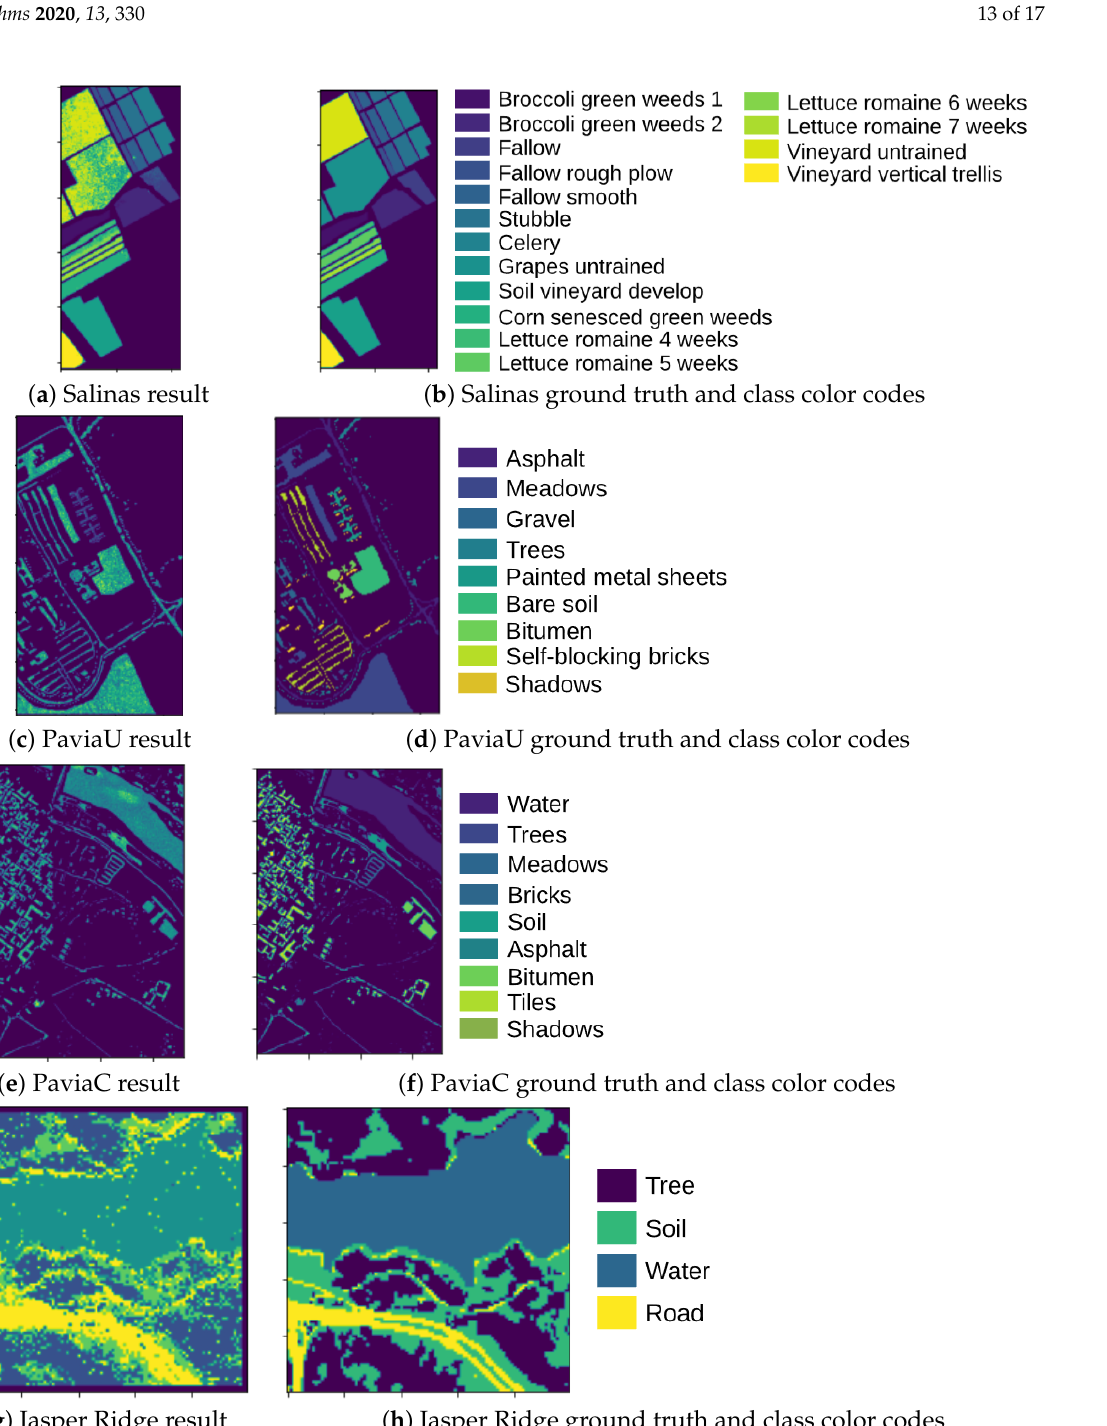
Figure 9. Cluster maps obtained from the proposed CLUS-BPT (left) and ground reference color codes of classes for Salinas, PaviaU, PaviaC, and Jasper Ridge scenes